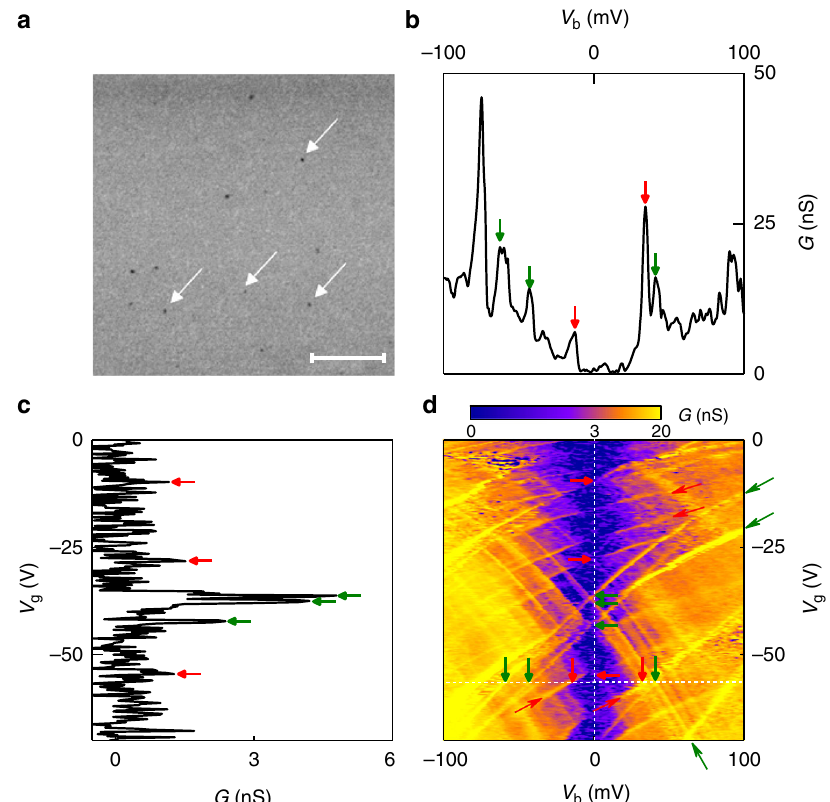
Fig. 5 Low-density non-periodic array of 10 nm GQDs embedded in hBN matrix and electron tunnelling transistors based on such GQDs. a SEM image of a GQD-hBN sample obtained after the transfer of hBN monolayer on Pt NPs/SiO 2 substrate and the conversion reaction. It shows GQDs with a long spacing (0.5 – 1.5 μ m), marked by white arrows. Scale bar 1 μ m. b The conductance G ( V g = − 56V, V b ) plot (extracted from d along the horizontal white dashed line). Arrows indicate peaks originating from boundaries of Coulomb diamonds (red) and from impurity-assisted tunnelling (green). c The conductance G ( V g , V = 0 mV) plot (extracted from d along the vertical white dashed line). Arrows indicate peaks originating from boundaries of Coulomb diamonds (red) b and from impurity-assisted tunnelling (green). d Conductance G ( V g , V b ) for a device with aperiodic 10 nm GQDs measured at T = 250 mK. Thick and short arrows indicate the crossing of the edges of the Coulomb diamonds (red arrows) and the impurity-assisted tunnelling peaks (green) with the white dashed lines. The positions of the arrows are the same as on b and c . Thin and long arrows indicate the edges of the Coulomb diamonds (red arrows) and the impurity-assisted tunnelling peaks (green